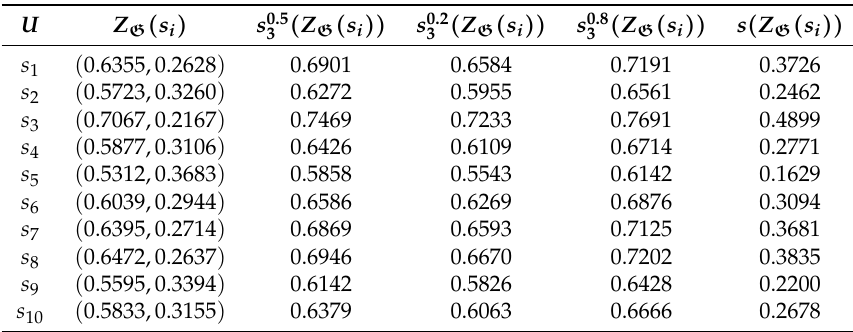
Table 6. OIFPVs and their scores with p = 3 and α =